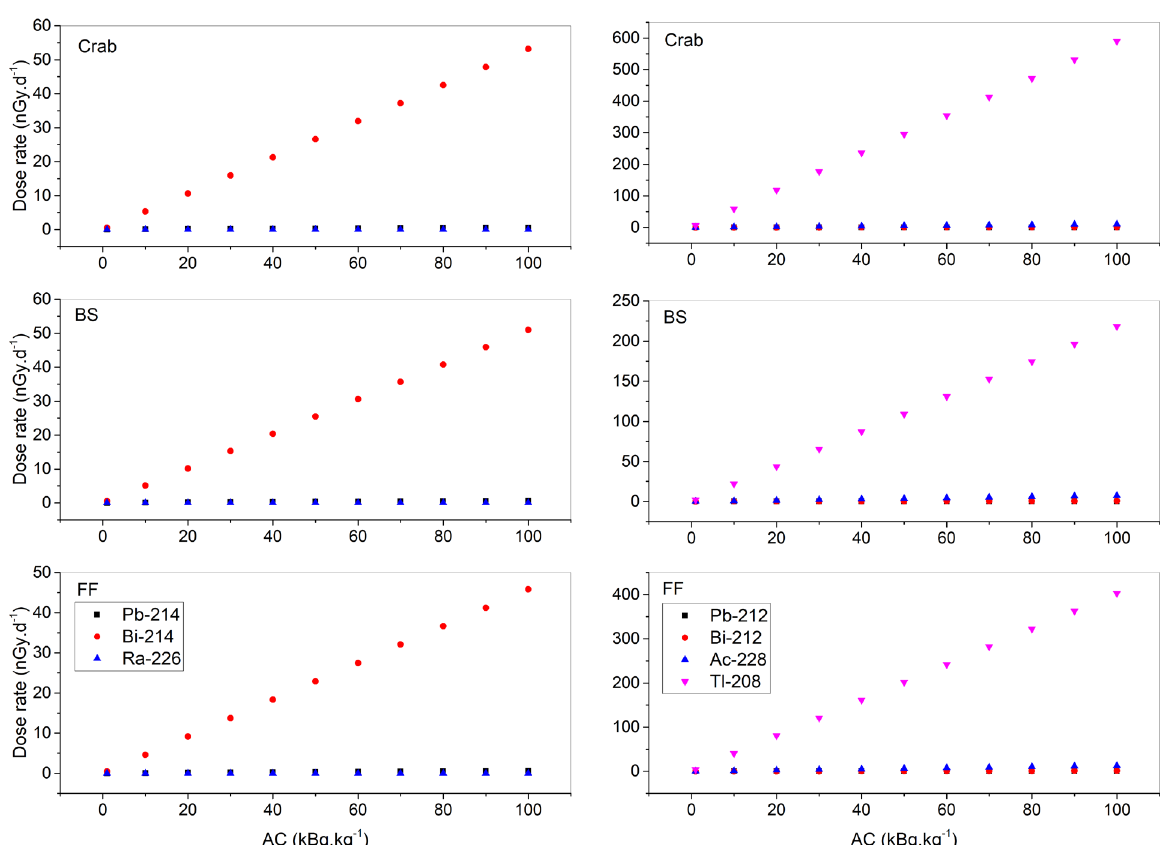
Figure 2. D due to the elements of uranium and thorium R